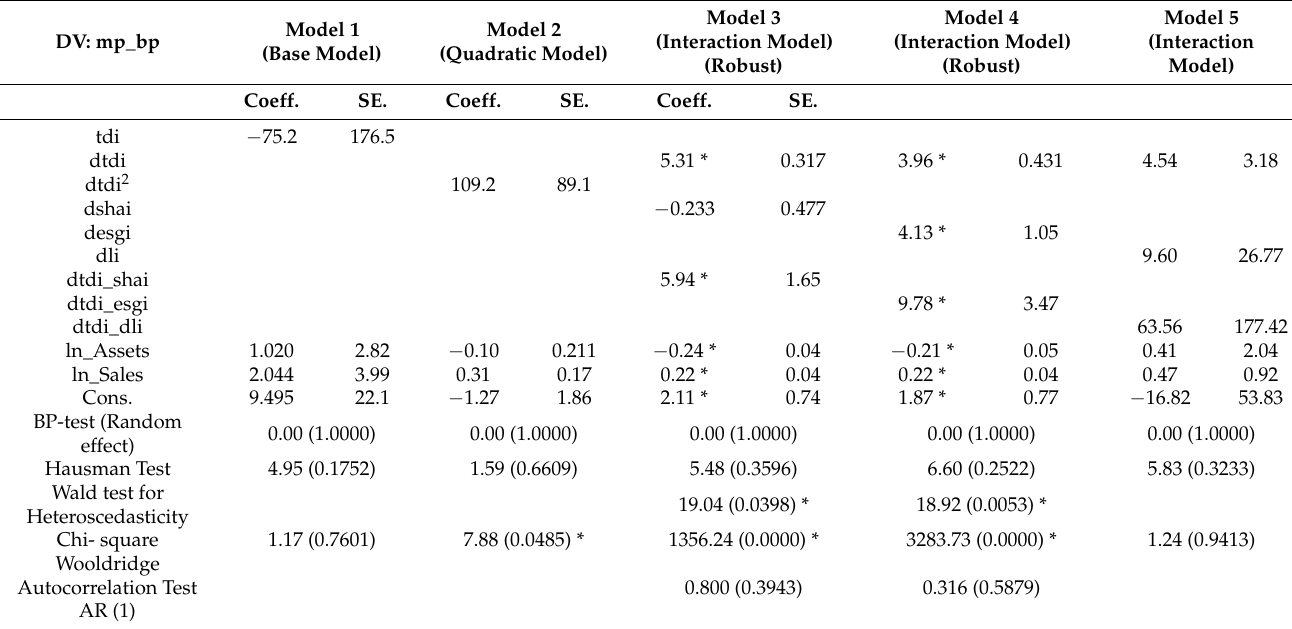
Table 5. Result (Static